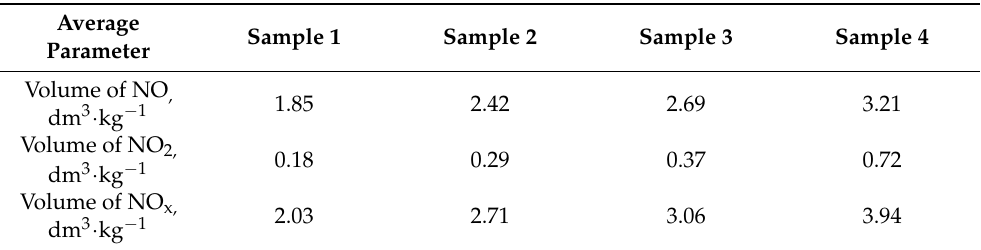
Table 5. Post blast volume of NO x after 10 min from the detonation microstructure charcoal enhancer of − 1.18 mm grain.